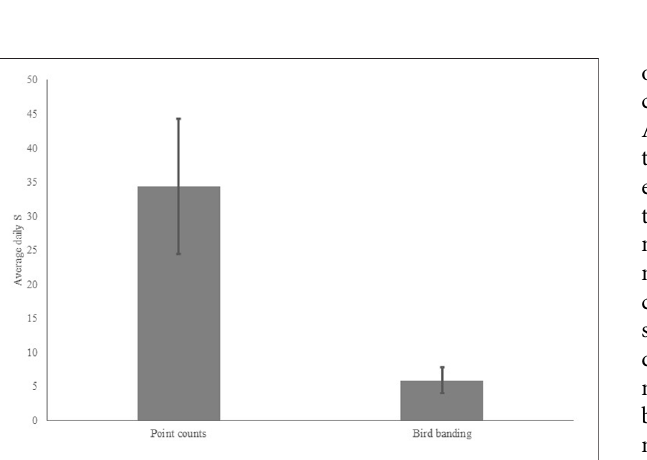
Frontiers in Environmental Science |